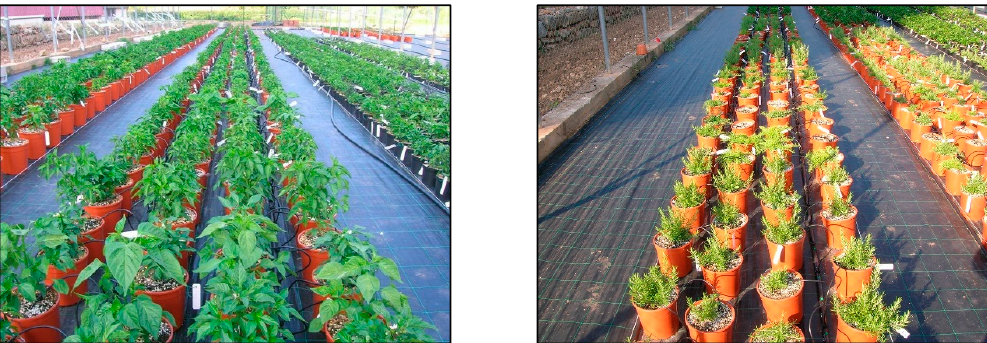
Figure 3. A view of the rosemary experimental field.